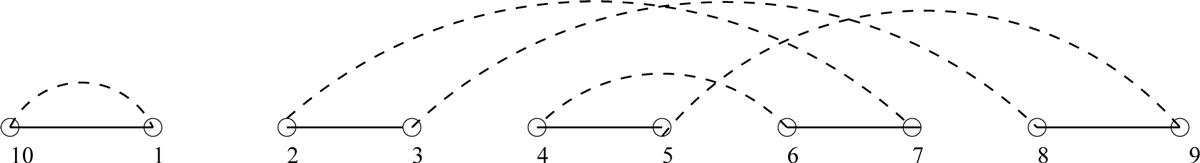
An example of breakpoint graph. Breakpoint graph of genome G = 1,2,-3,4,-5, with respect to the identity genome G = 1,2,3,4,5.